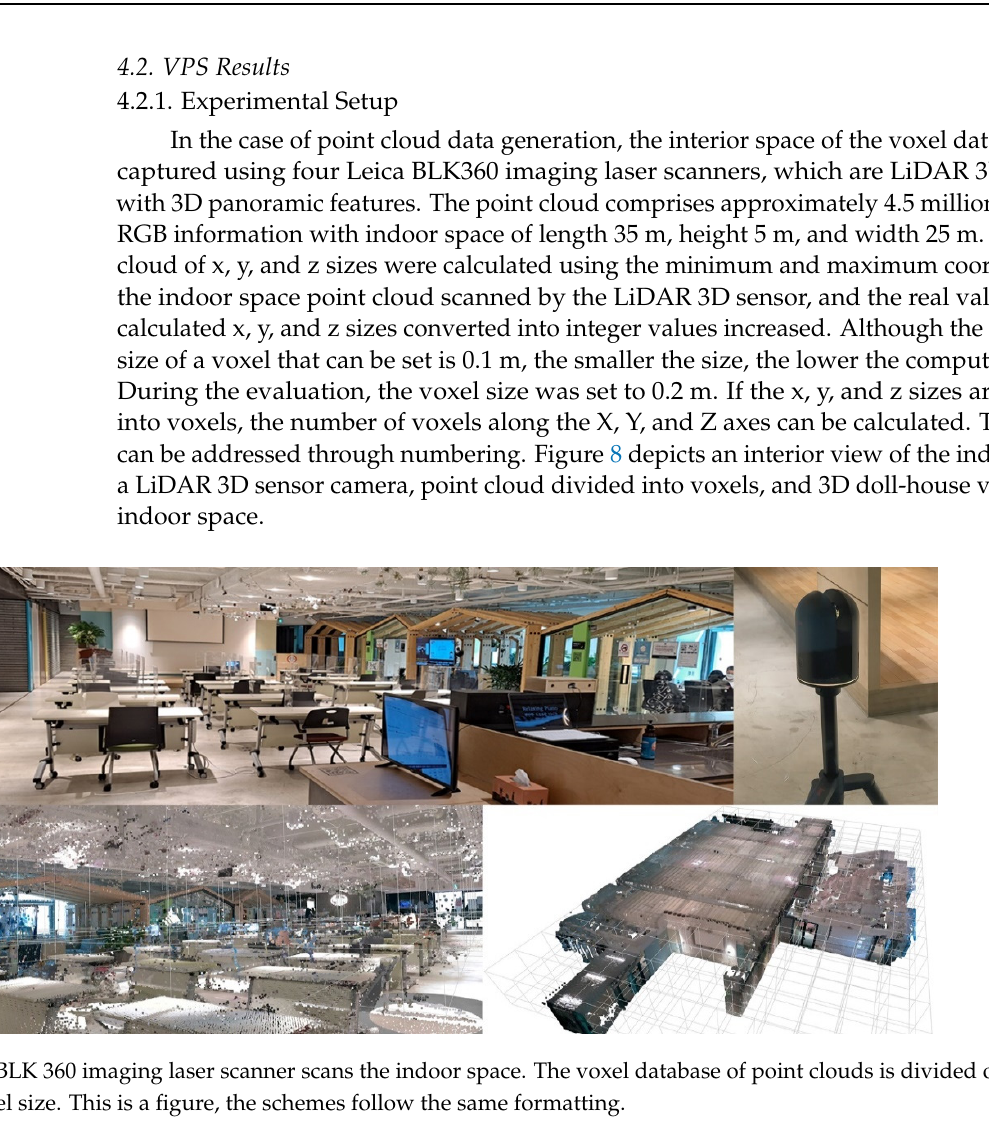
Table 4. Visual positioning system (VPS) log.